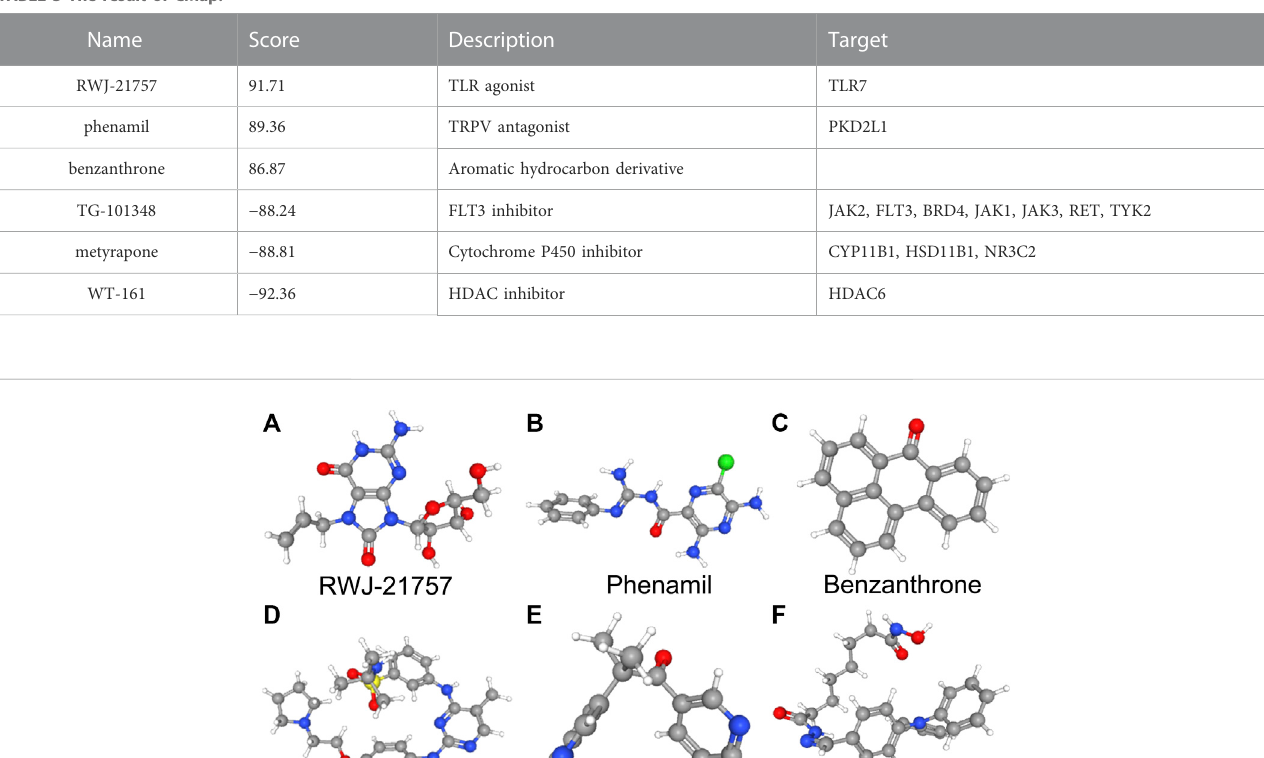
TABLE 3 The result of CMap.